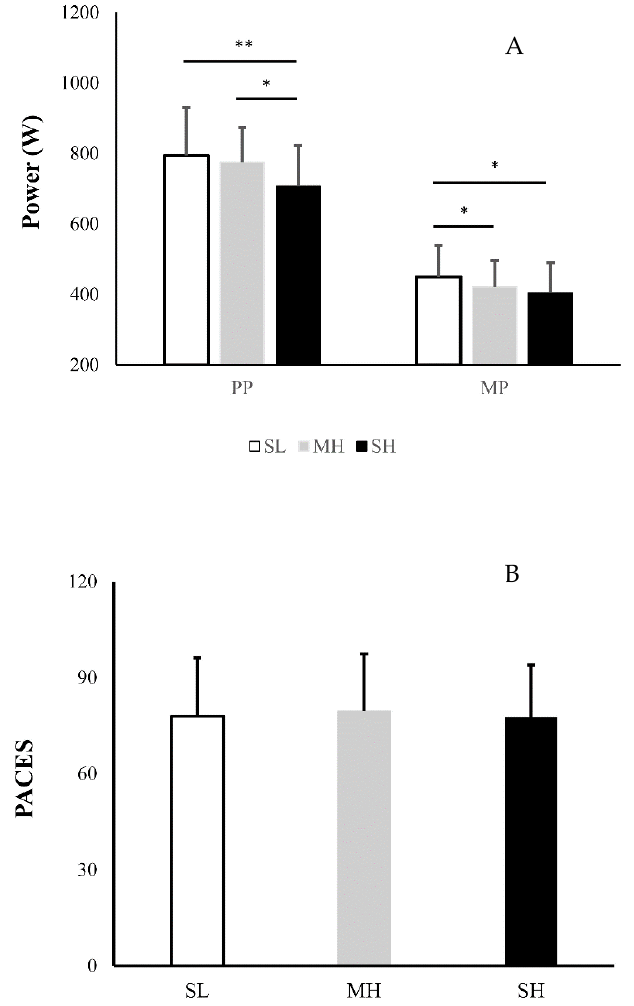
Figure 2. Power outputs during exercise ( A ) and scores of physical activity enjoyment scale (PACES) (mean and standard deviation) ( B ) after sprint interval exercise at different hypoxia. * p < 0.05, ** p < 0.01. SL: sea level; MH: moderate hypoxia; SH: severe hypoxia; PP: peak power; MP: mean power. Table 1. Physiological and psychological responses to sprint interval exercise at different hypoxia SL MH SH Pre Post Pre Post Pre